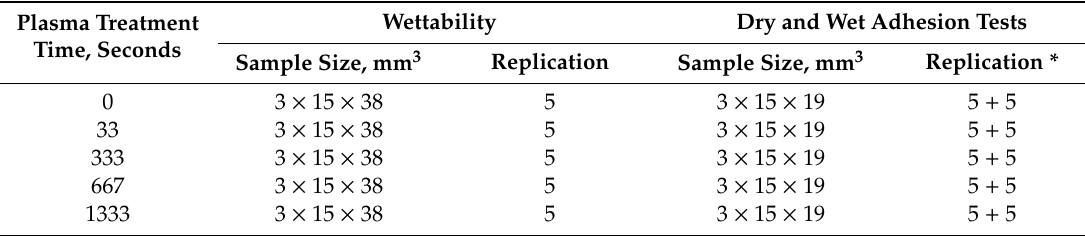
Table 1. Treatments, sample sizes, and replication for an experiment that examined the e ff ects of plasma treatment on the wettability and adhesion of a white acrylic primer to hot-oil modified blue stained lodgepole pine